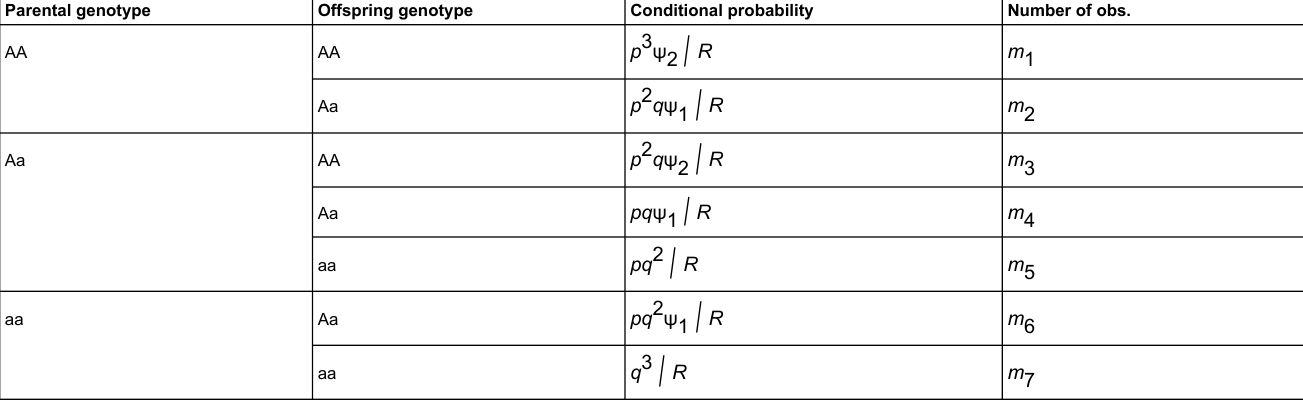
Table 2: Conditional probabilities of parental genotype and the offspring genotype given that the offspring is affected (for the dyad families). Parental